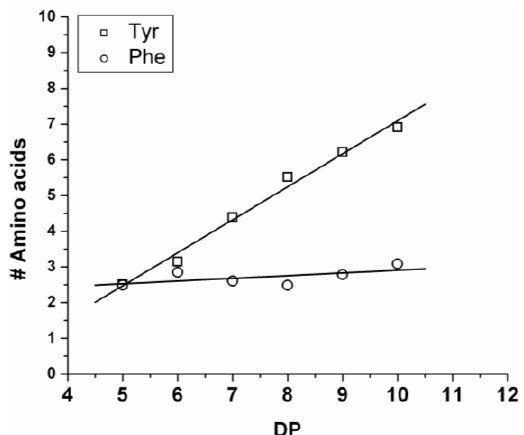
Figure 5. Average number of amino acid residues in poly(Tyr-co-Phe) for every observed degree of oligomerization